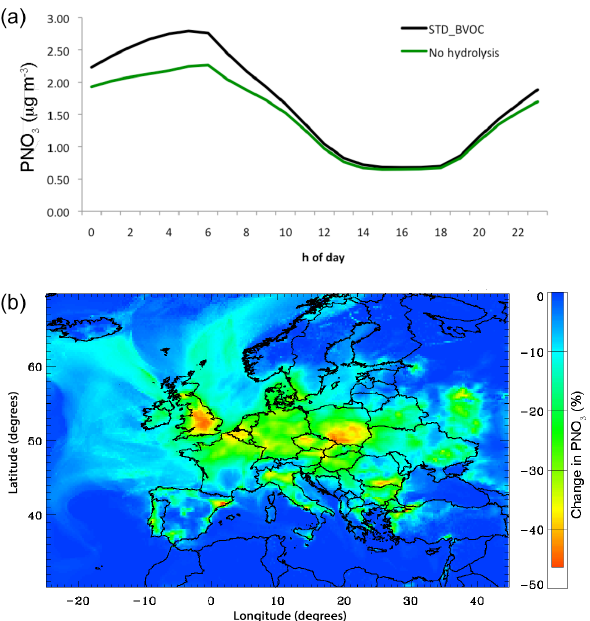
Figure 7. (a) Change in the diurnal cycle of particulate nitrate con- centrations when hydrolysis reaction of N 2 O 5 was switched off (Payerne, average June 2006). (b) Change in PNO 3 concentrations (%) in whole model domain when hydrolysis reaction of N 2 O 5 was switched off (June